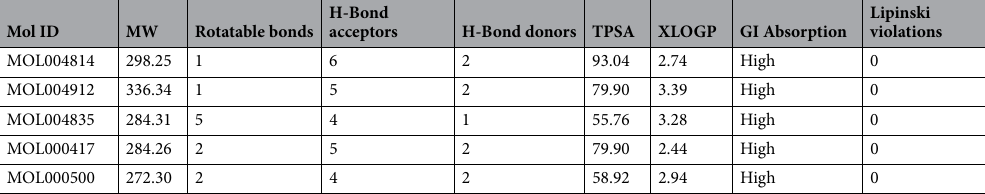
Table 6. Lead-like compounds.